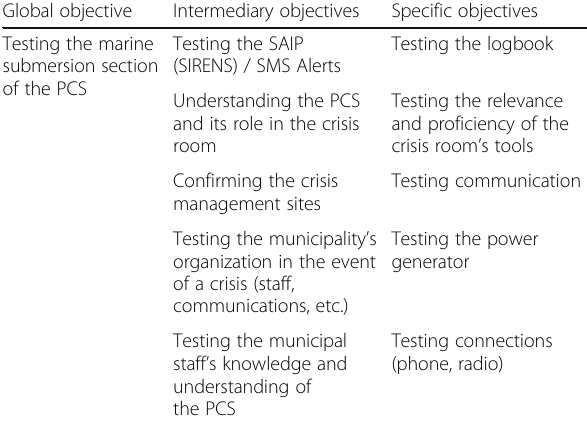
Table 4 Extract from the objectives of the March 2016 exercise